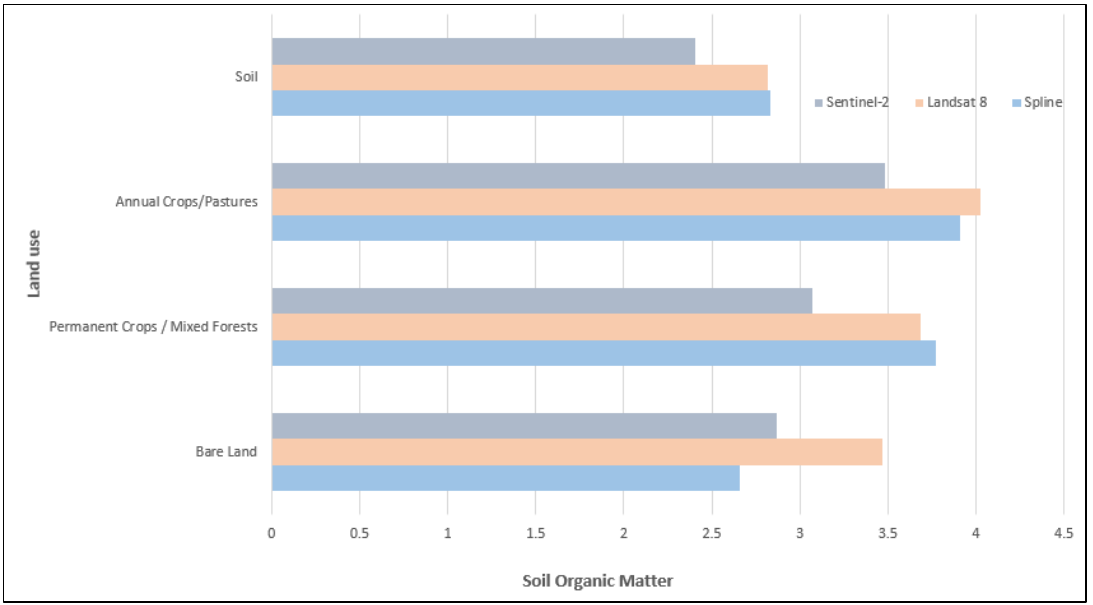
Figure 10. Soil erosion [Revised Universal Soil Loss Equation (RUSLE)] map of the study area.